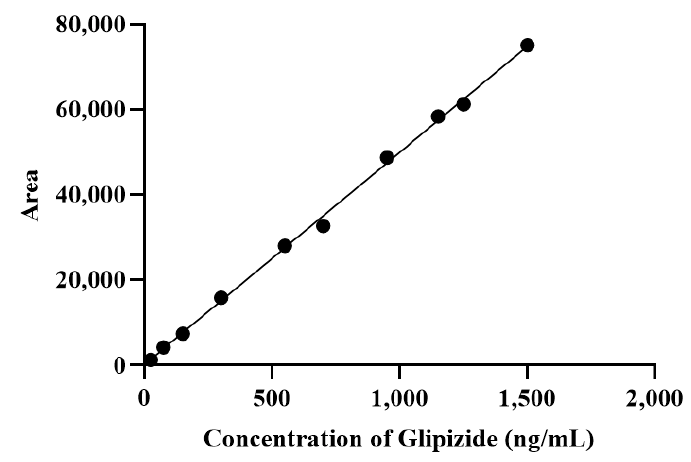
Figure 2. Calibration curves for glipizide using HPLC to determine the relationship between concentration and peak area. The equation obtained was y = 49.858x + 143.83 (R 2 = 0.9983), F value = 4812.72.